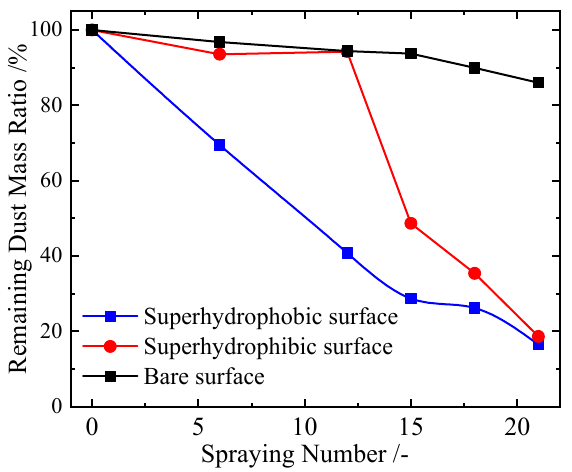
Figure 10. Dust deposition mass on solar cell covering glass with and without coating. Figure 11. Dust deposition mass on solar cell covering glass with and without coating.